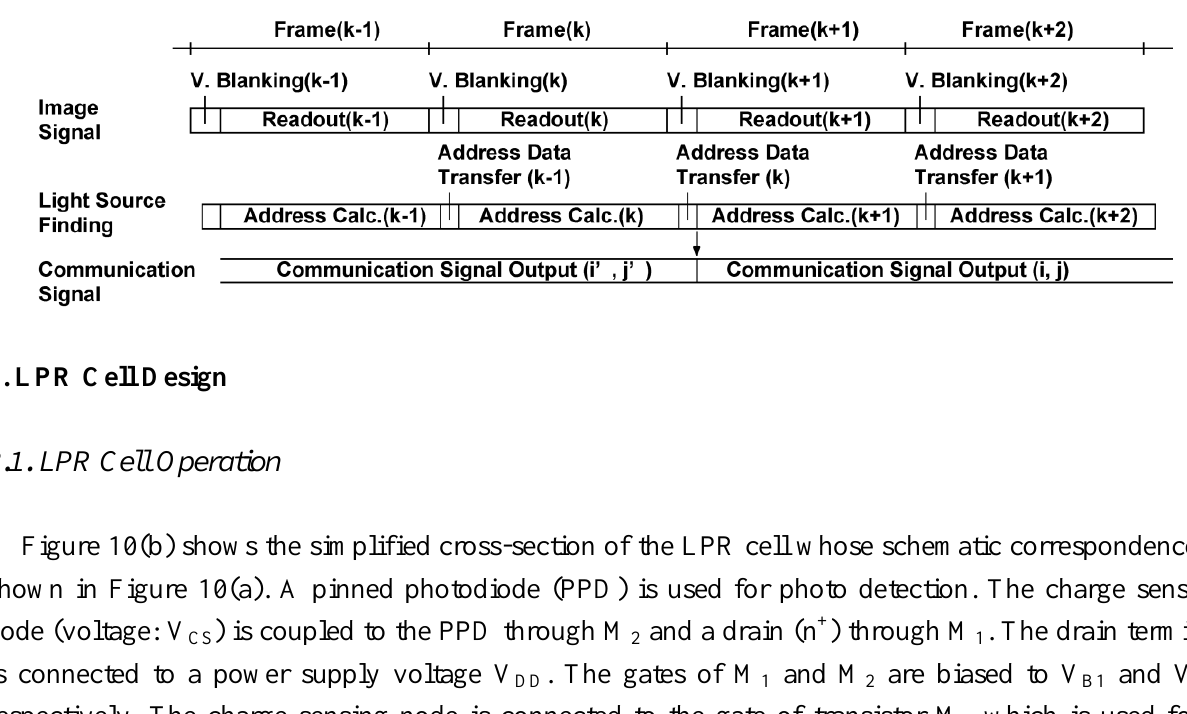
Figure 9. Timing diagram of the image signal readout, light source address calculation and communication signal output.